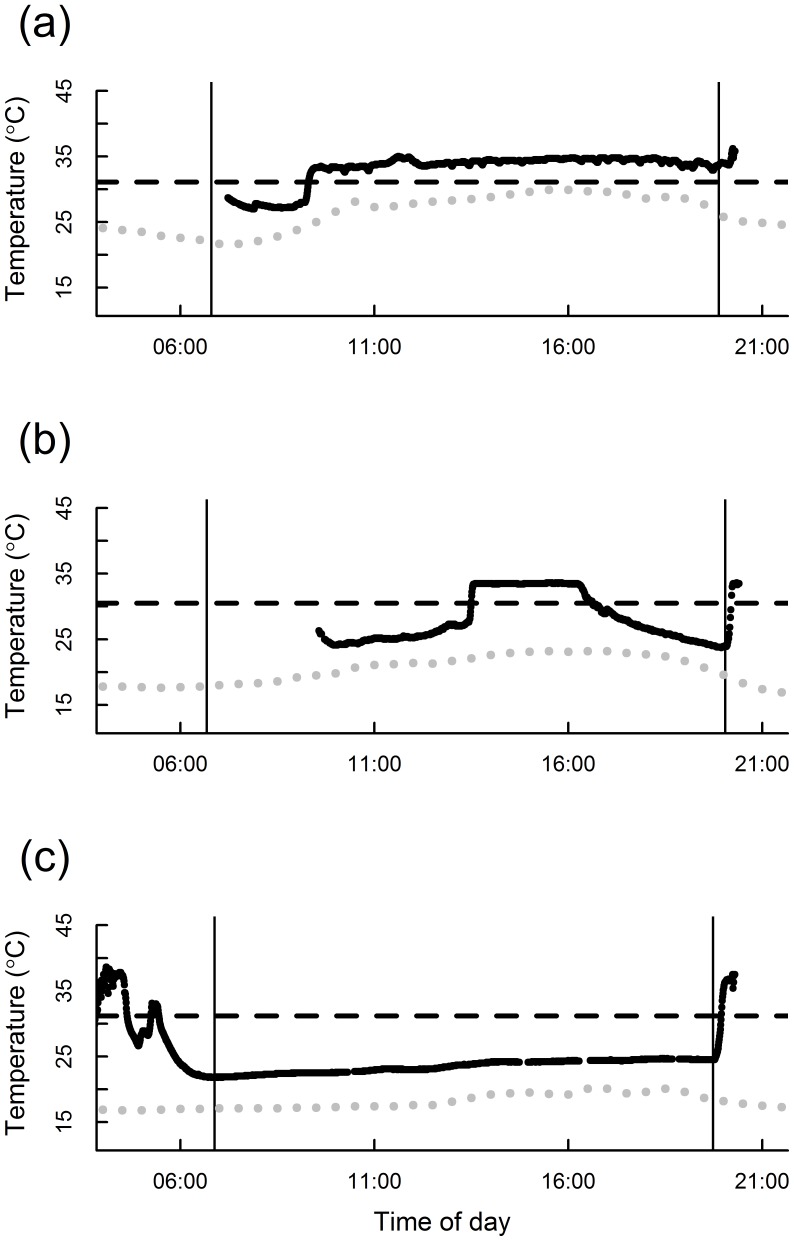
Temperature profiles of free-living silver-haired bats during autumn migration.Vertical lines indicate sunrise and sunset, horizontal dashed line indicates the individually determined threshold below which the bat was considered torpid (see Materials and Methods), black dots indicate skin temperature, and gray dots indicate ambient temperature. The amount of time spent torpid depended on ambient conditions. Mean ambient temperature over the period of observation was 27.4°C (Sept 3), 21.9°C (Aug 28), and 18.3°C (Sept 8) in panels (a), (b), and (c) respectively. Accordingly, in (a) the bat spent only a brief period of the morning in torpor, whereas at cooler temperatures bats spent most (b) or all (c) of the day torpid.